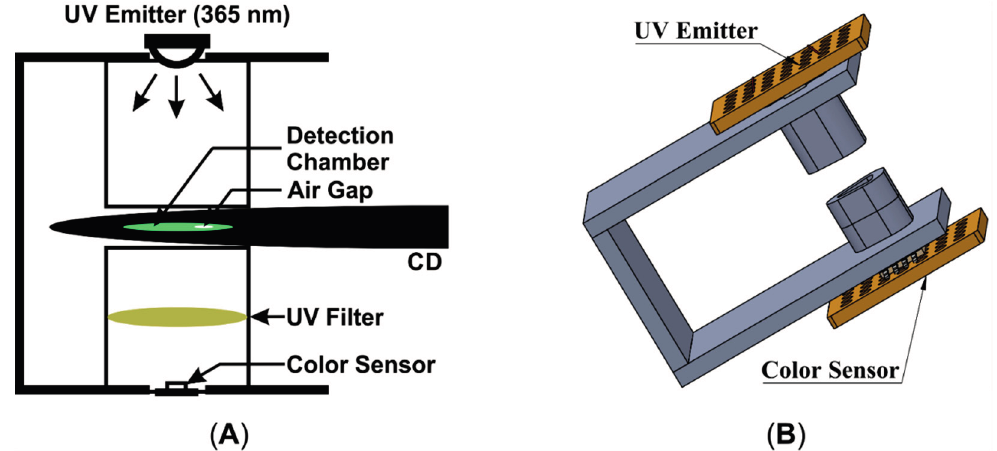
Figure 4. Sensor holder ( A ) Schematic illustration in 2D; ( B ) Schematic illustration in